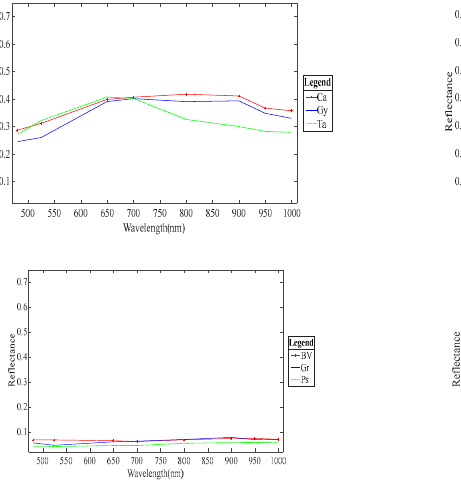
muscovite (Mu), hematite (He), calcite (Ca), galena (Gal), kaolinite (Ka), talcum (Ta), pyrite (Pyr), chal-